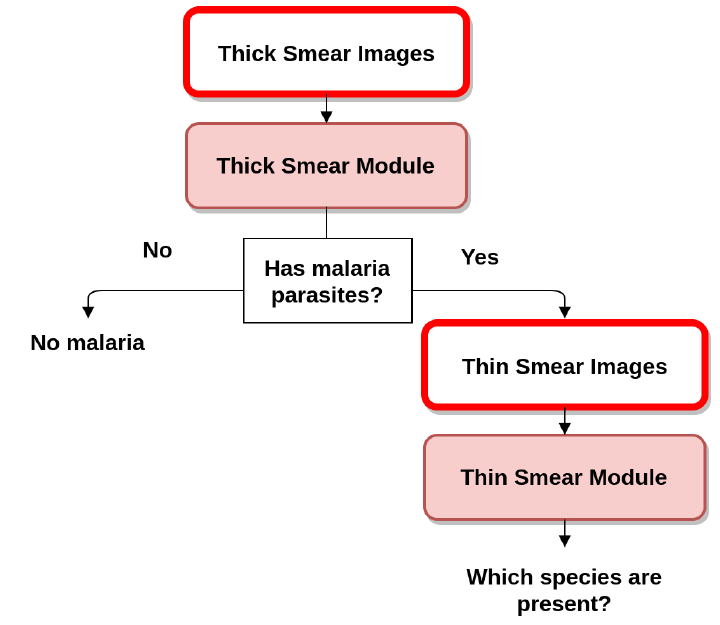
Figure 1. Blood smear analysis flow for both quantification and species/life cycle stage